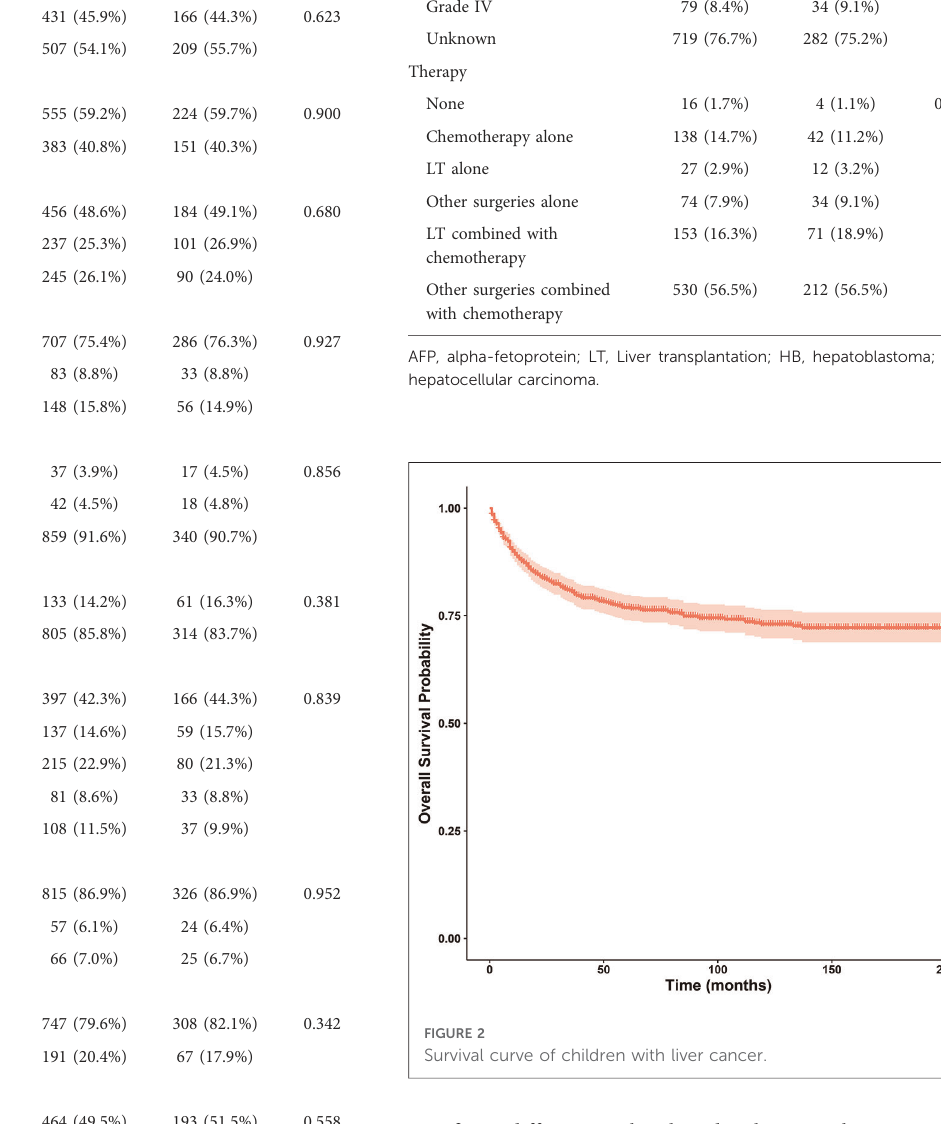
signi fi cant difference in baseline data between the training and testing datasets ( Table 1 ). The AUCs of 1-year, 3-year, and 5- year OS predicted by all patients were 0.841, 0.820, and 0.829, respectively ( Figure 5A ), while the AUCs of 1-year, 3-year, and 5-year OS predicted by the testing dataset were 0.858, 0.838, and 0.848, respectively ( Figure 5B ). Patients were divided into high-risk-level and low-risk-level groups based on the risk score calculated according to our model. We found that the prognosis of the low-risk-level group was signi fi cantly better than that of the high-risk-level group ( p < .05) ( Figures 5C, D ). Therefore, our model could well judge the